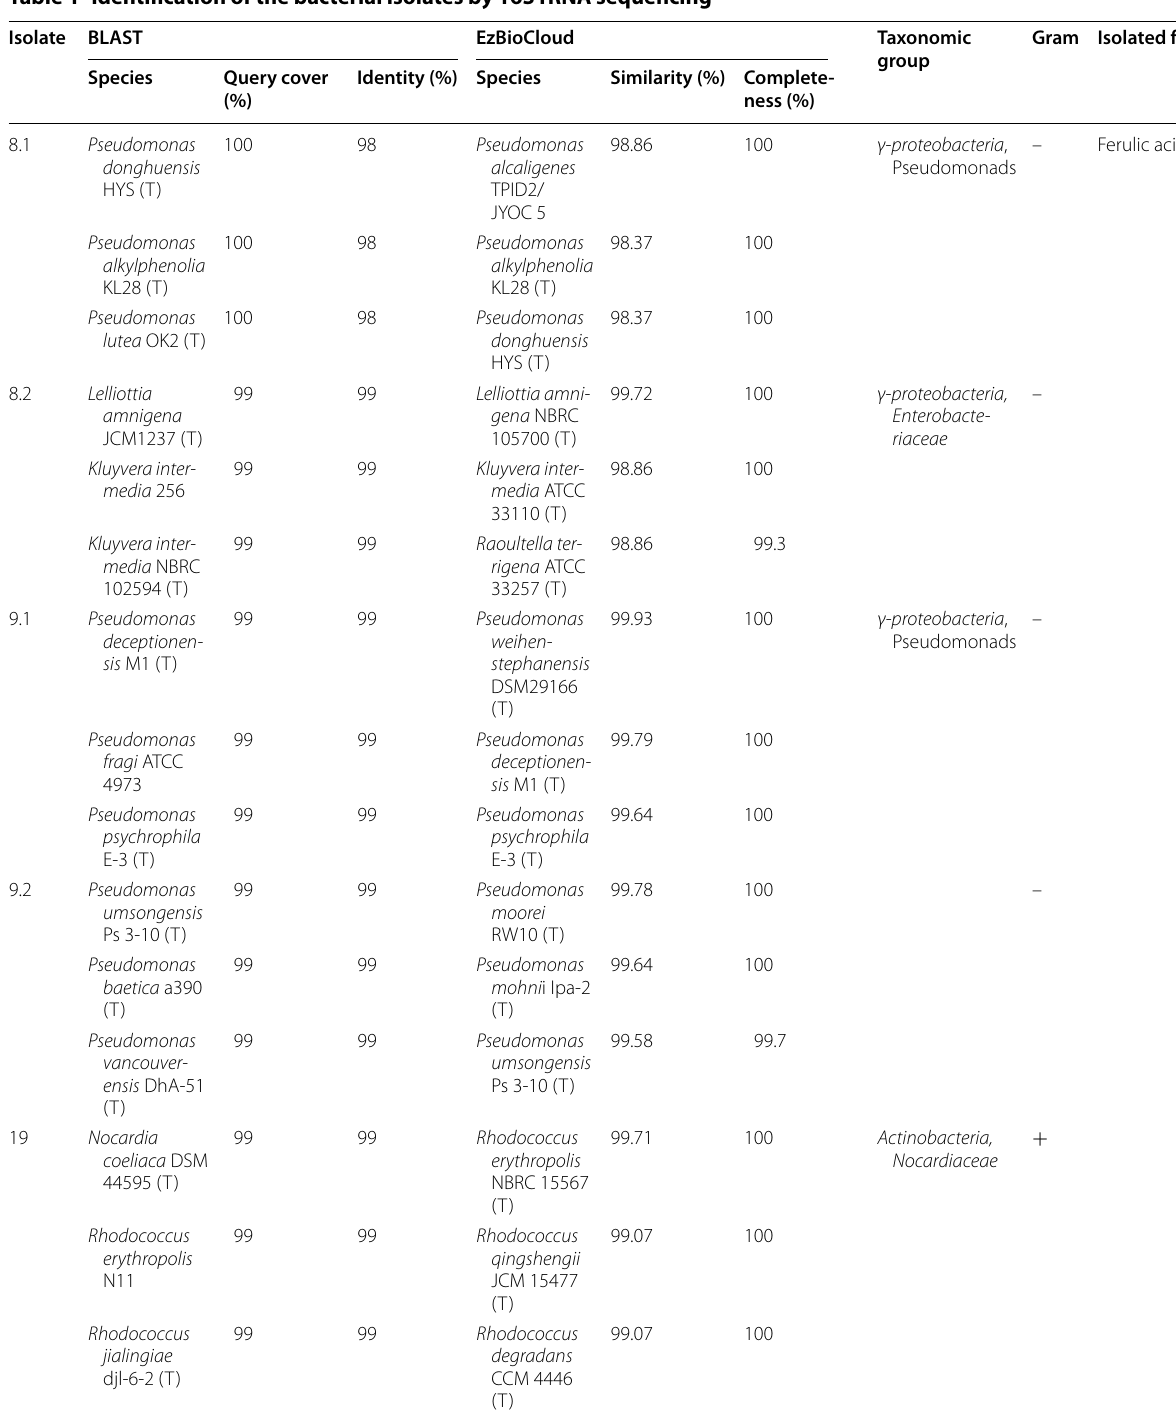
Table 1 Identification of the bacterial isolates by 16S rRNA sequencing Isolate